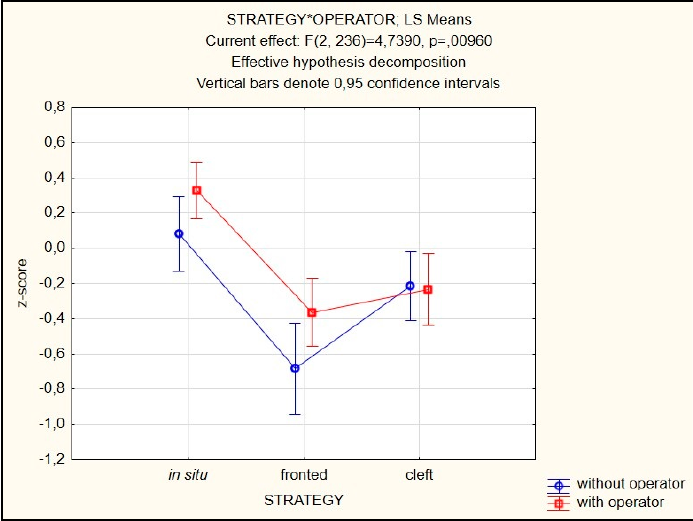
Figure 20. Strategy*Operator interaction (Italian) .